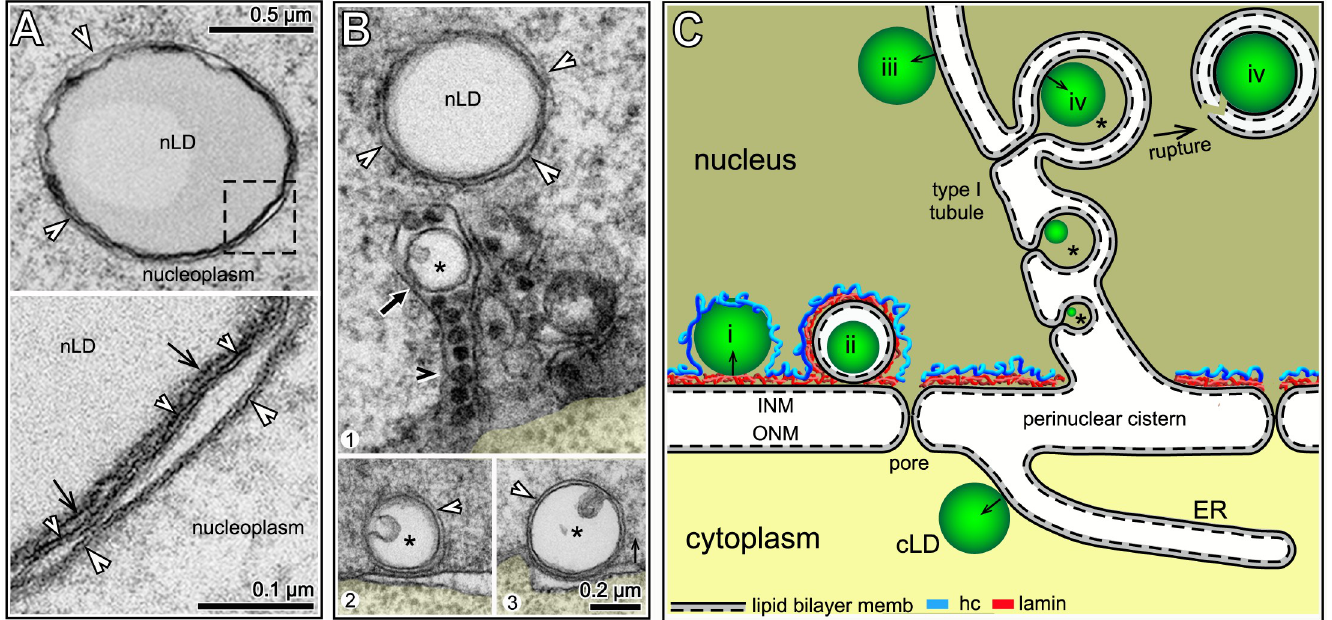
Fig 5. Membrane-enclosed nLDs. (A) TEM of tubule-associated nLD with extra membranes (white arrowheads) in a D2 nucleus; see also Fig 4C and 4D . The high magnification inset (bottom) shows that the nLD surface (black arrows) is partially surrounded by two membranes (small and large white arrowheads), both of which have the sandwich appearance of lipid bilayers. (B) Panel 1 shows a tubule-associated nLD with extra membranes (white arrowheads), and a nested vesicle (black arrow) inside a tubule; the tubule contains several electron-dense granules (black arrowhead). The nested vesicles have an internal domain (asterisk) resembling a small lipid droplet; see similar nested vesicles in Fig 4C and 4D . Panels 2 and 3 show structures resembling nested vesicles, but located by the nuclear envelope. (C) Summary model for the origin of the different classes of nLDs observed in this study. For comparison, a cLD is shown budding from an ER membrane; note polarity of budding with respect to the two lipid leaflets (solid and dashed lines). Class i nLDs likely form from the INM (see Fig 2H ) and split the peripheral heterochromatin (blue) from the lamina; class ii nLDs (kernel vesicles, see text) are covered by both lamin and heterochromatin; class iii nLDs bud from INM-derived type I tubules. We propose that class iv nLDs (asterisks) form at an inpocketing of the tubule membrane. A class iv nLD eventually ruptures the tubule, and enters the nucleoplasm with variable fragments of the folded tubule membrane.